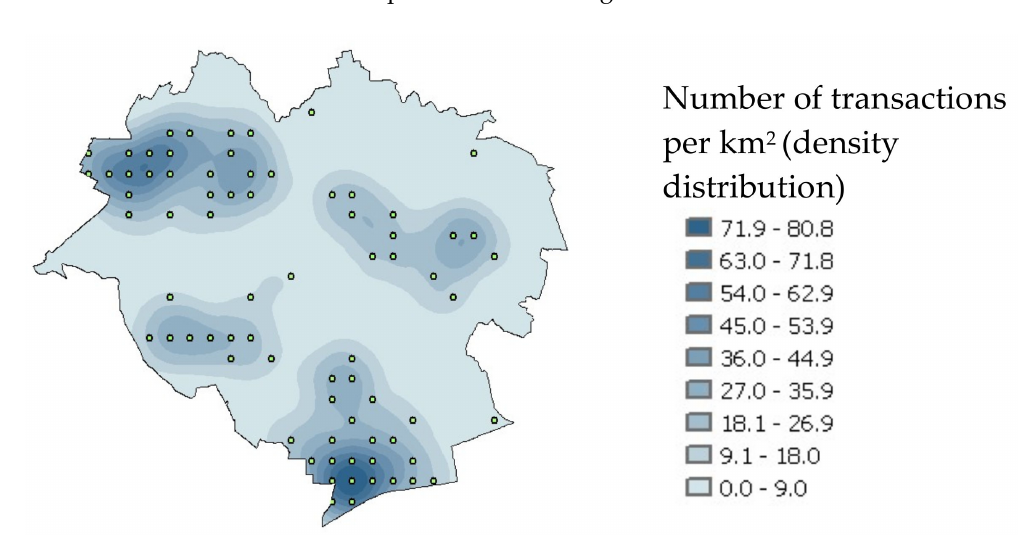
Figure 9. The spatial distribution of the input data—simulated transaction in a real estate market (points denote centroids of basic fields as objects of possible transactions) and density of simulated transactions using the kernel